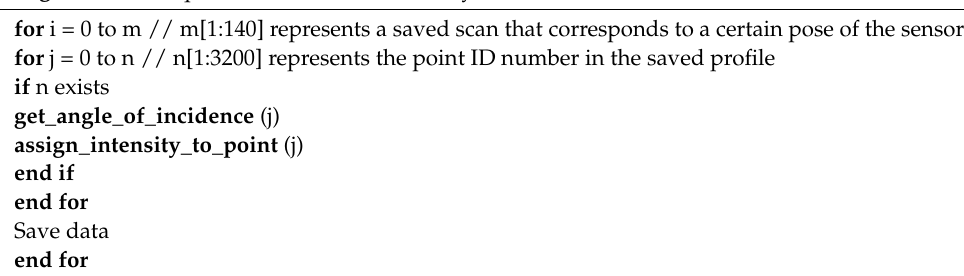
Figure 11. Schematic of the laser ray geometry for computation of AoI of i-th laser ray. Algorithm 2. Acquisition of reflected intensity